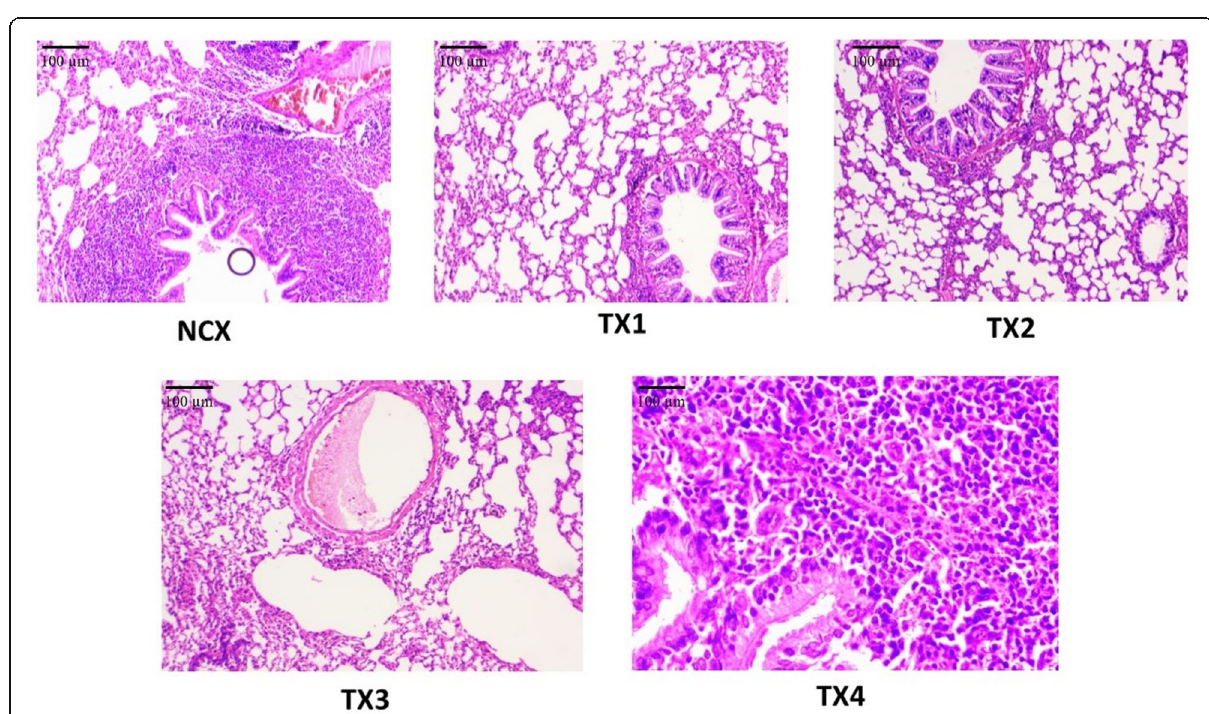
Fig. 4 The histopathology of lung from the different group of swiss albino mice (40 × magnification; Scalar bar: 100 μ m). All treated groups showed normal lung architecture. No significant damage (such as Granulomas, increased alveolar cell wall, Inflammatory cells) was observed in the lung tissue of any treated groups rats. The section showed intact alveolar membrane when compared to normal control group (NCX). Where NCX: Normal control group; TX1: Sub-acute toxicity group 1 (250 mg/kg/day/p.o); TX2: Sub-acute toxicity group 2 (500 mg/kg/day/p.o); TX3: Sub- acute toxicity group 3 (1000 mg/kg/day/p.o); TX4: Sub-acute toxicity group 4 (2000